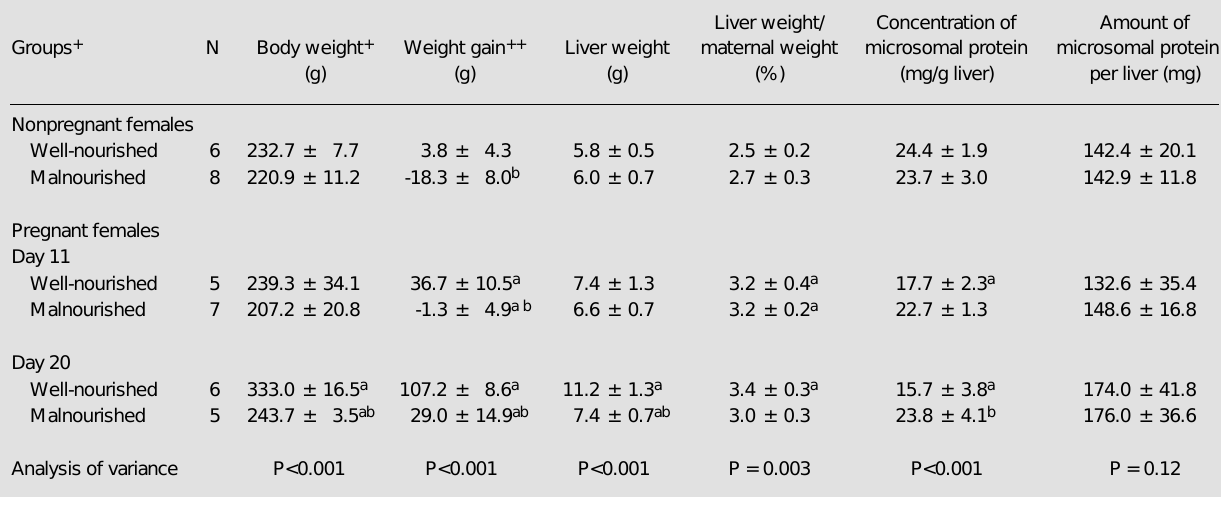
Table 1 - Effect of pregnancy and malnutrition on rat liver microsomal protein. Data are reported as means ± SD. + Well-nourished rats were fed ad libitum . Malnourished rats received only 12 g of food per day from pregnancy day 0 on. Nonpregnant malnourished females were on a food restriction regimen for 20 days before sacrifice. + Weight on the day of sacrifice. ++ Pregnant females: weight on the day of sacrifice - weight on pregnancy day 0. Nonpregnant females: weight on the day of sacrifice - weight 20 days before sacrifice. Weight gain and relative liver weight were analyzed by the Kruskal-Wallis test followed by the Mann-Whitney U-test. All other parameters were evaluated by one-way ANOVA followed by the Student t -test. a P £ 0.05 compared to the respective WN or MN nonpregnant group; b P £ 0.05 compared to the WN group on the same pregnancy